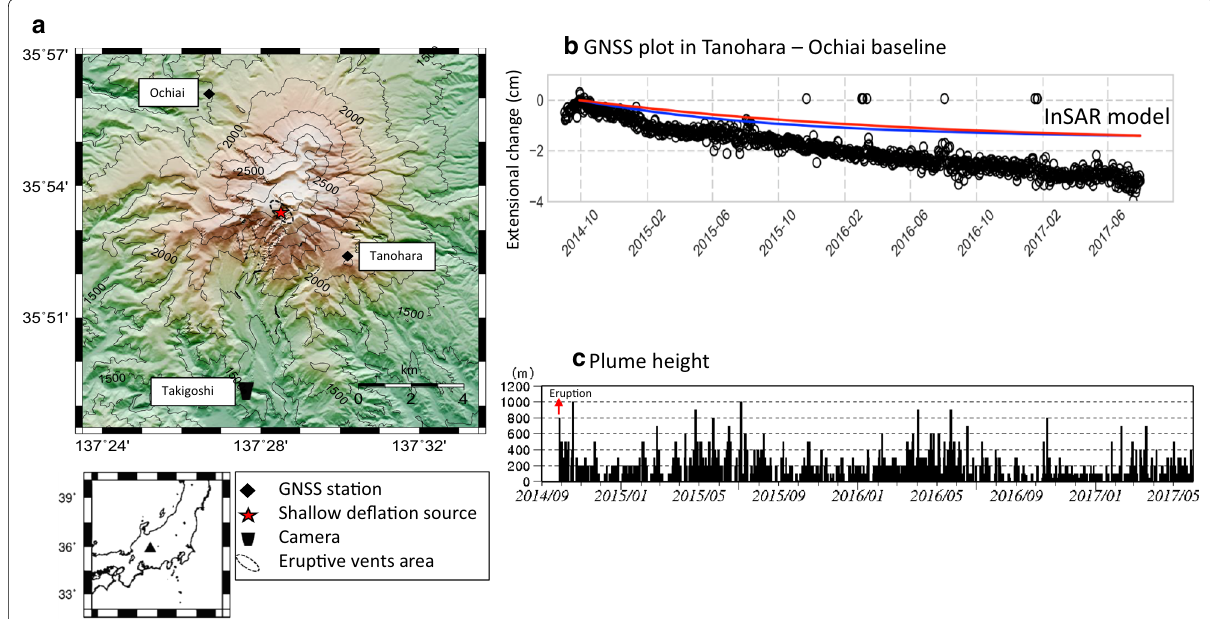
Fig. 1 a Locations of GNSS and camera stations. b GNSS plots of Tanohara–Ochiai baseline length from September 2014 to July 2017. The GNSS data were provided by Japan Meteorological Agency (JMA). Red and blue lines show baseline length change predicted by the shallow deflation source model derived from two orbital data of ALOS-2 satellite (Narita and Murakami 2018); path 126, an orbit of ascending and right-looking (the red line) and path 20, an orbit of descending and right-looking (the blue line), respectively. c Plume height above the vent area (JMA